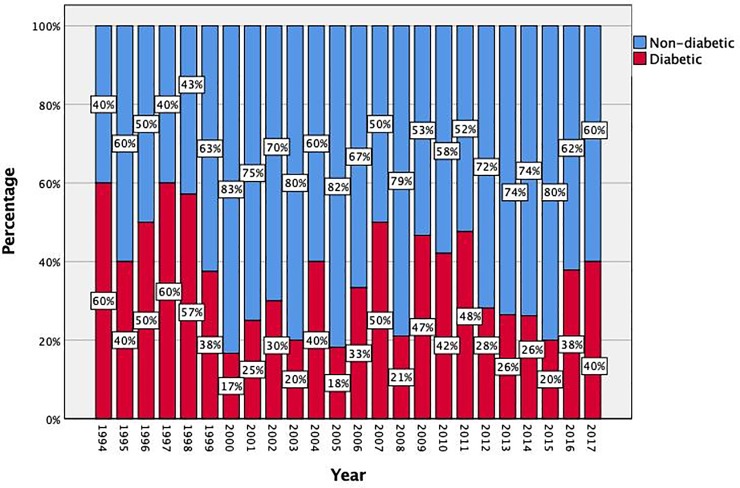
Bar graph showing the relative percentage of diabetic/non-diabetic patients over the years.The percentage of diabetic patients does not show a substantial increasing/decreasing trend during the study period.